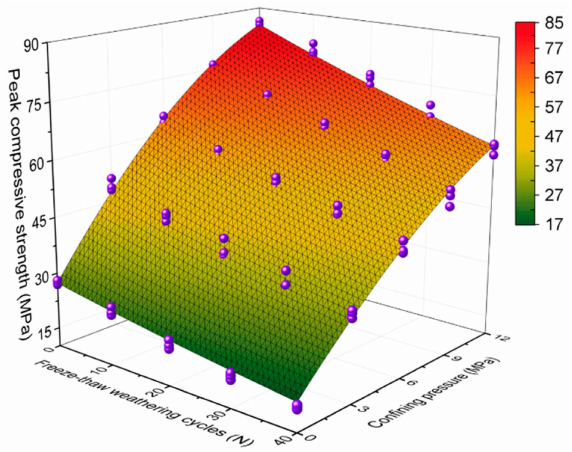
Figure 14. Fitting results of TCS of sandstone specimens for different quantities of F&T weathering cycles and different confining pressures. Table 3. Fitting parameters of strength evolution model of sandstone